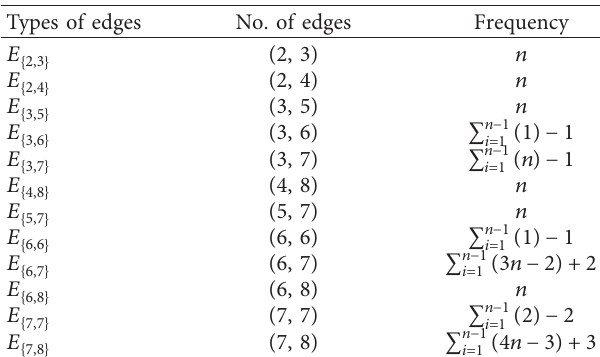
Table 6: Edge partition based on the degree sum of end vertices of each